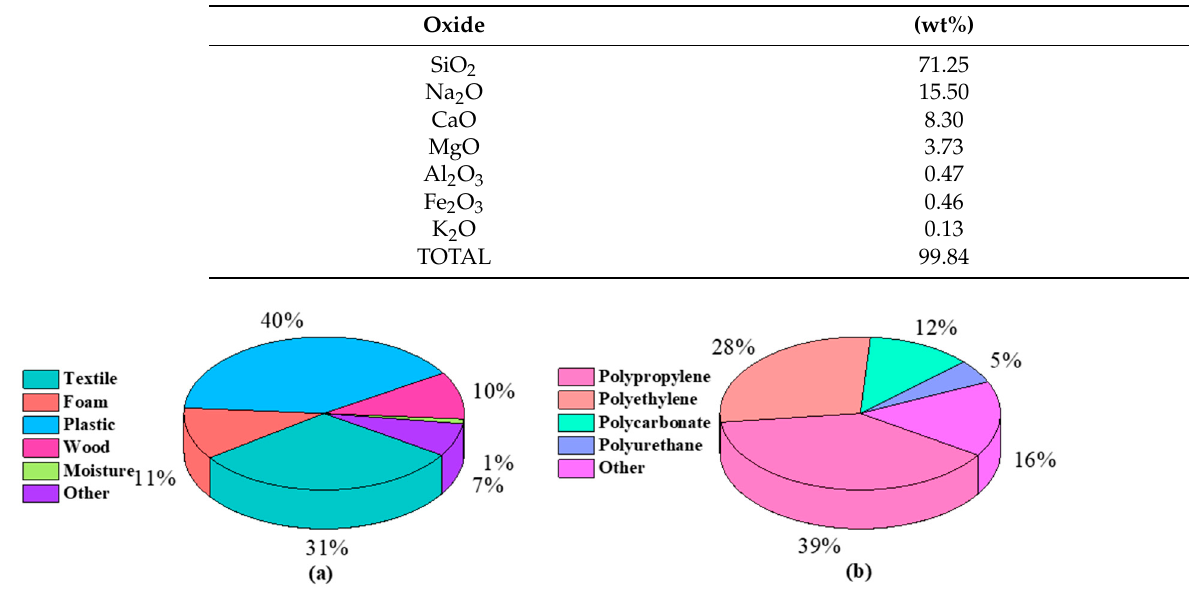
Table 1. Major oxides in the windshield glass done by XRF.